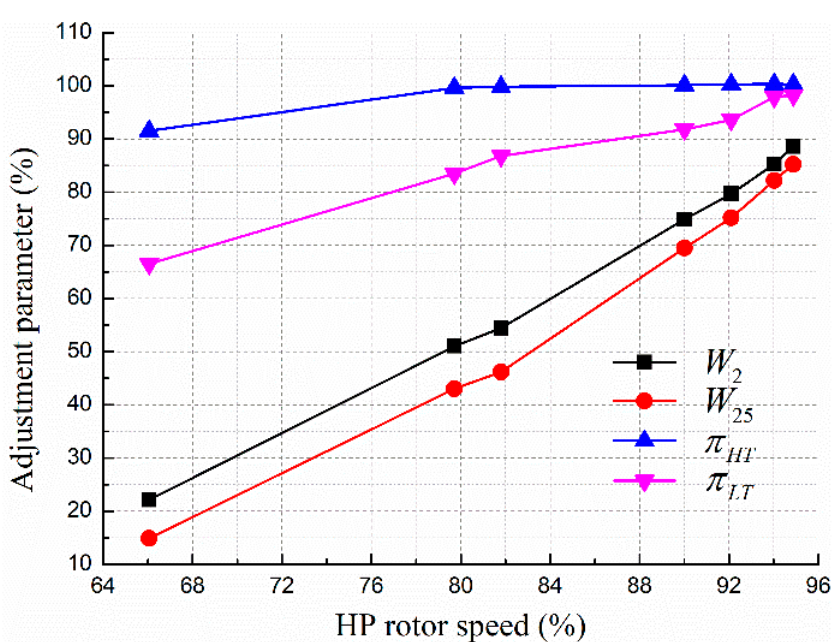
Figure 8. Adjustment parameters in the model adaptation.